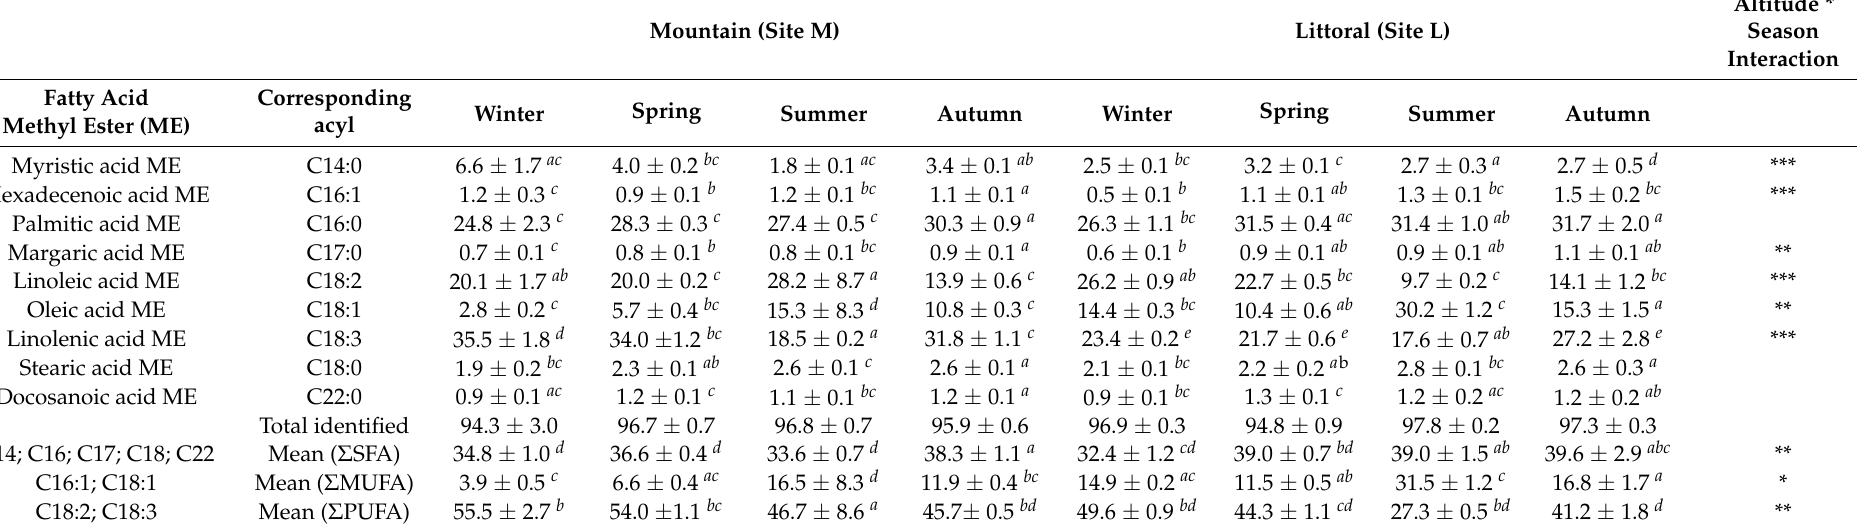
Table 4. FAME analysis of the acyl lipids extracted from lentisk leaves. The levels of each compound are expressed as chromatographic relative peak surface measured as total ion current (area % TIC). The extraction yield for each lipid fraction was similar: 1.95 ± 0.05 g/100 g of dry